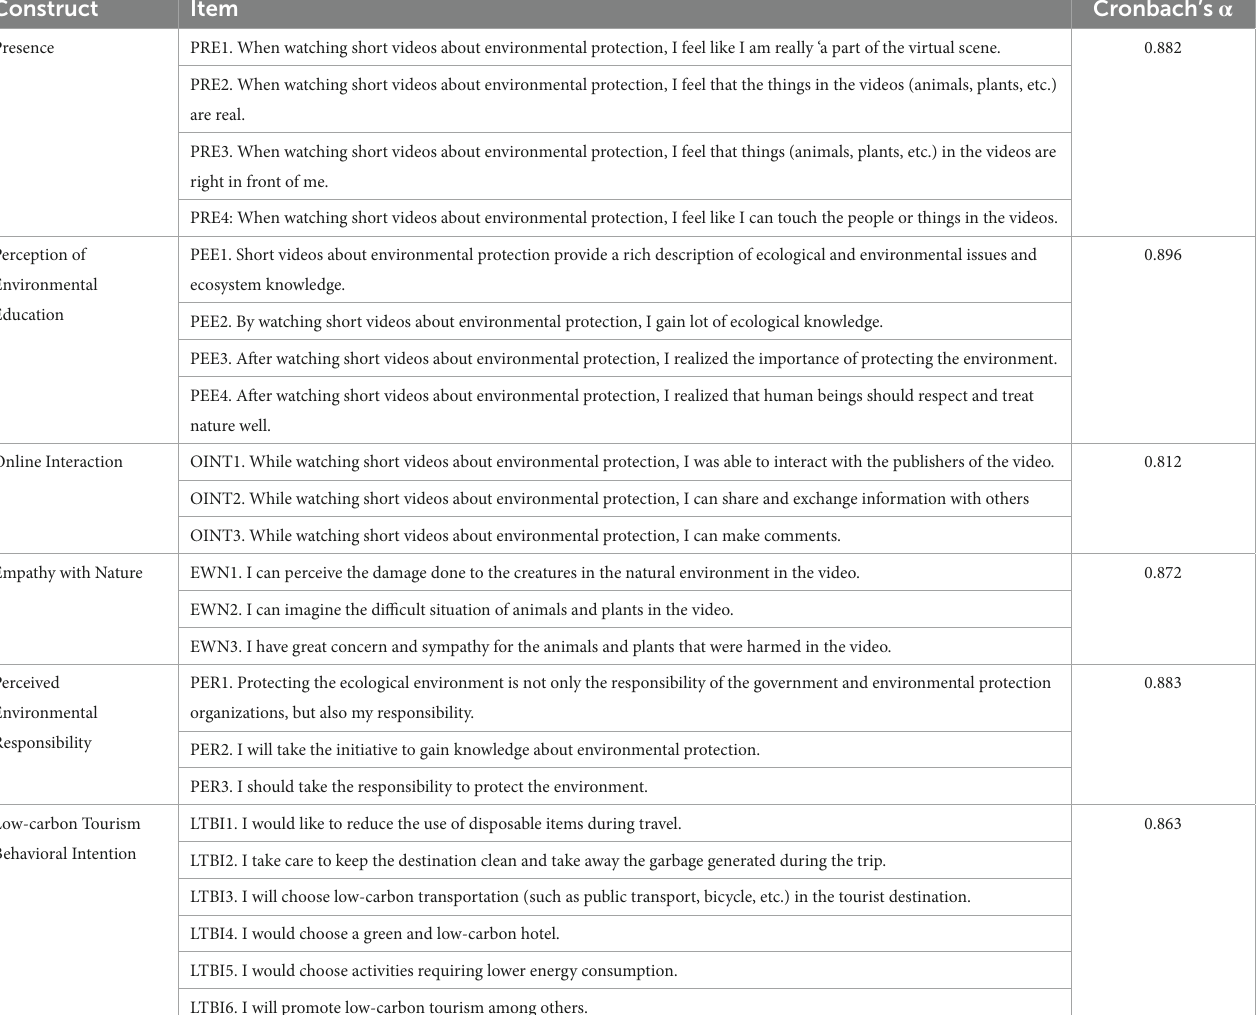
TABLE 1 Scale items and reliability test.